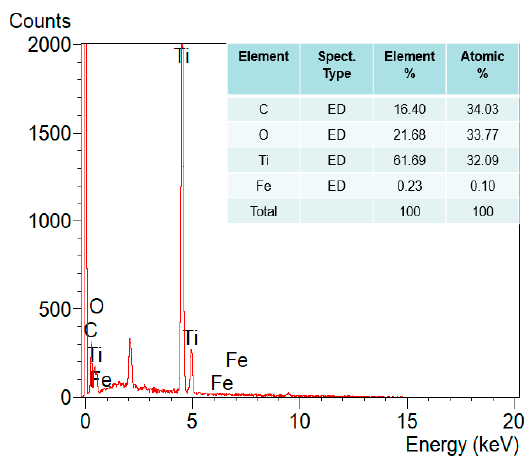
Figure 10. EDS graphs of the workpiece before and after the magnetic abrasive finishing process (under optimal conditions: 1 μ m, 3 mm, 2000 rpm, 300 s).